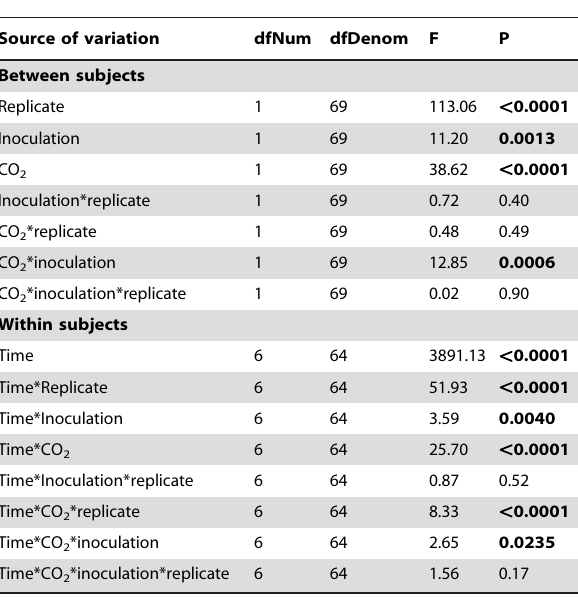
Table 1. Results of the ANOVA with repeated